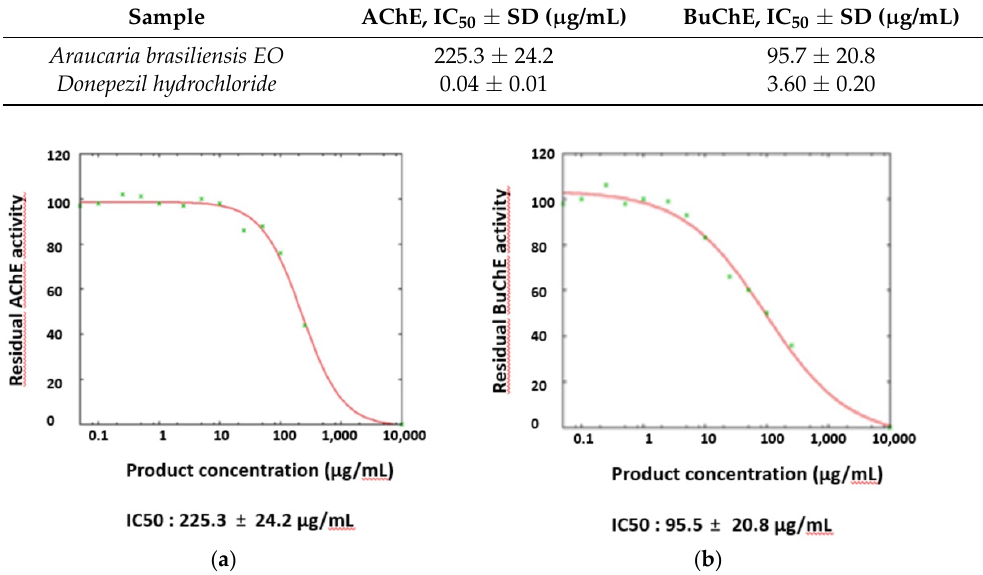
Figure 4. Calculation of the IC 50 values of Araucaria brasiliensis EO towards ( a ) acetylcholinesterase (AChE) and ( b ) butyrylcholinesterase (BuChE). Table 3. Cholinesterase inhibitory activity.